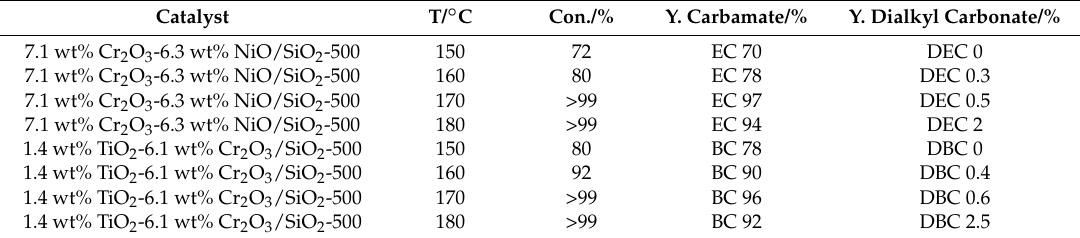
Table 6. Effect of reaction temperature on synthesis of EC and BC * . Catalyst T/ ◦ C Con./% Y. Carbamate/% Y. Dialkyl Carbonate/%